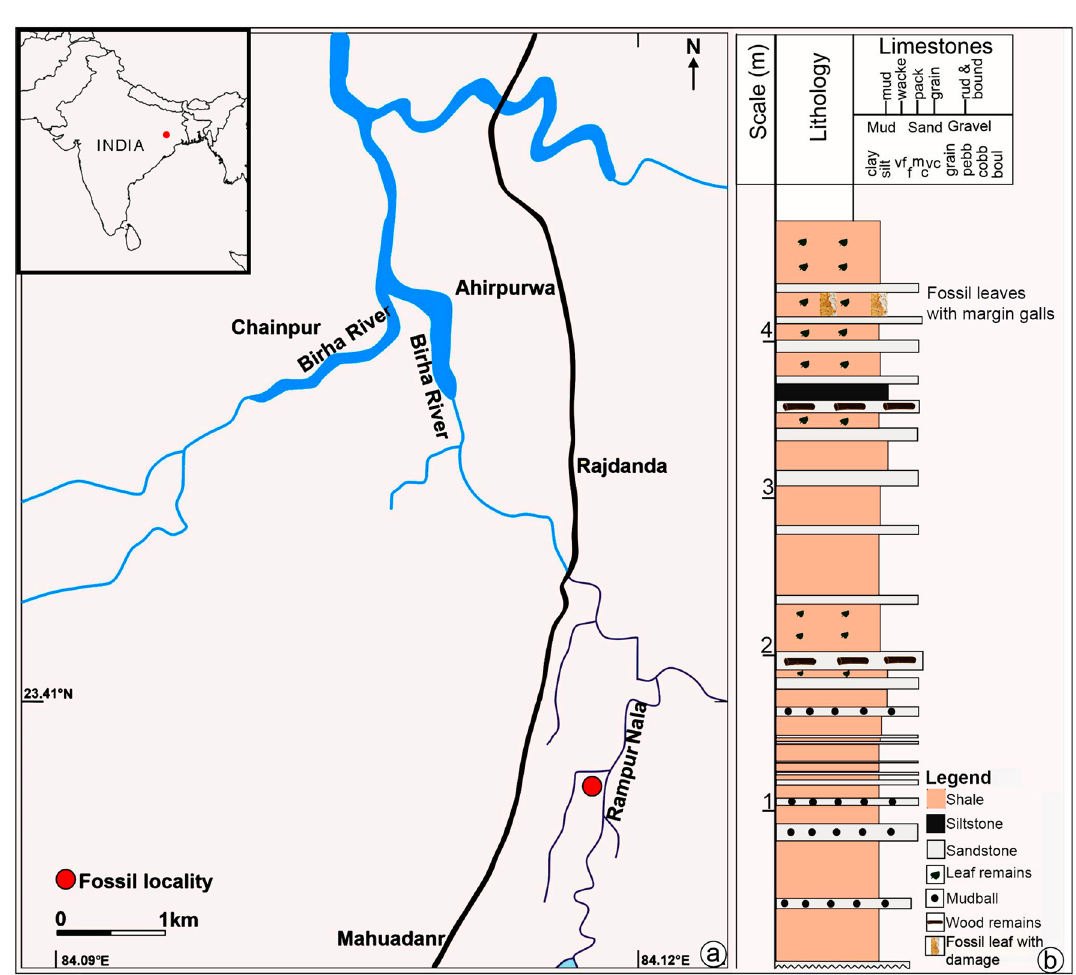
Figure 1. ( a ) Map of India indicating the location of Mahuadanr, Latehar district, Jharkhand (a part of the district resource map of Palamu district, Bihar published under the direction of Director General,